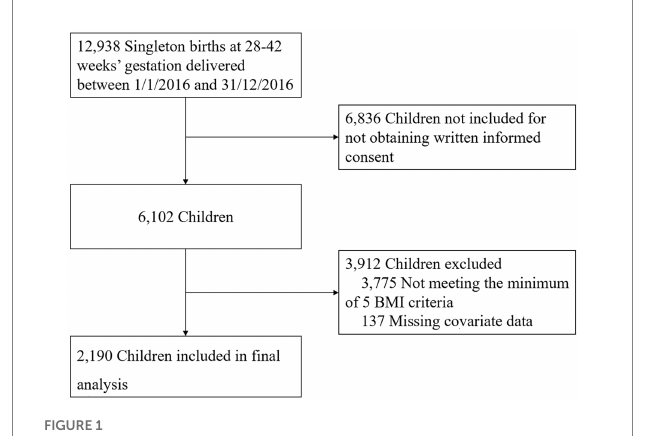
FIGURE 1 Study cohort